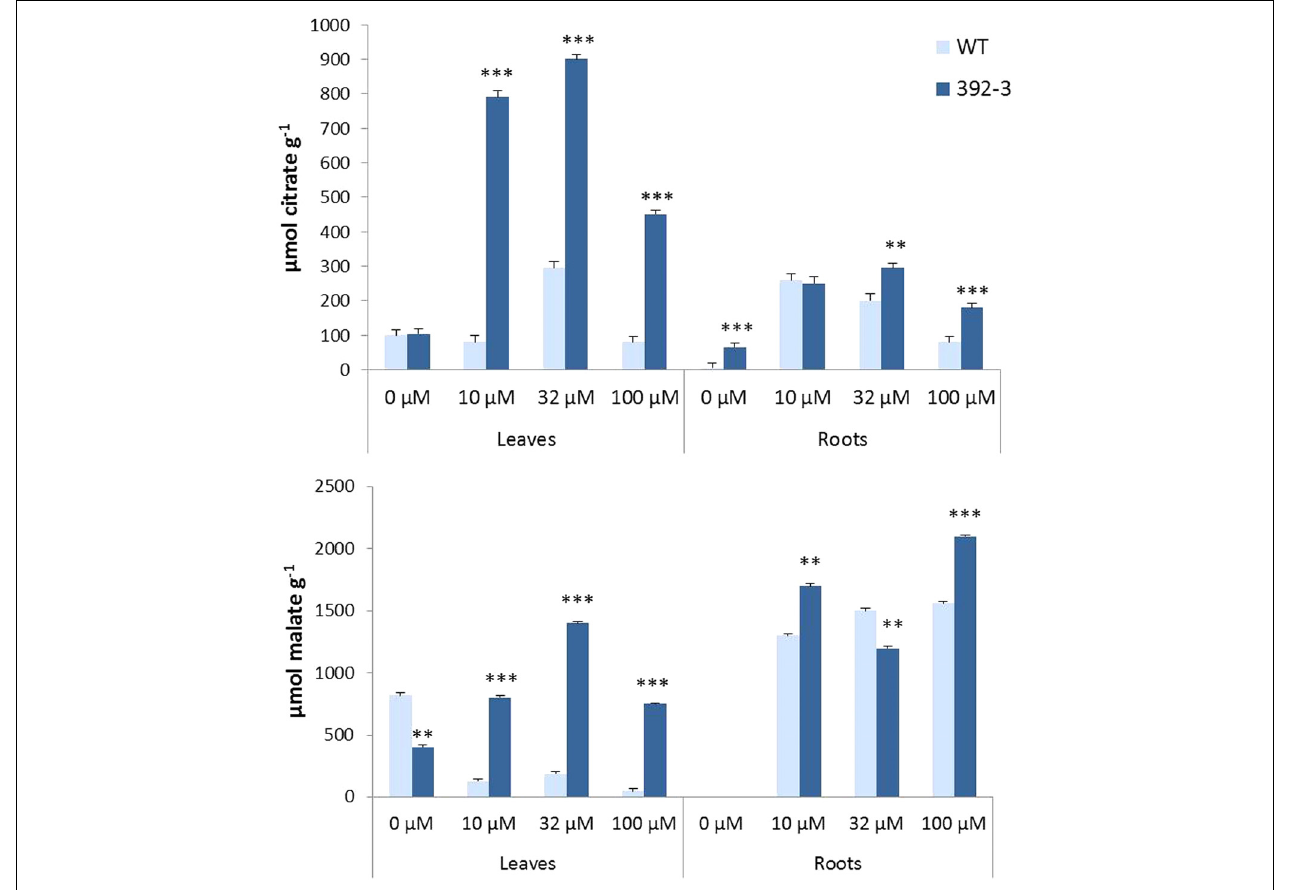
FIGURE 9 | Effects of Fe concentration on organic acid (citrate and malate) accumulation inWT and 392-3 soybean leaves and roots. Data are means ± SE of eight replicates. Asterisks represent significant differences betweenWT and 392-3 (** P < 0.01; *** P <